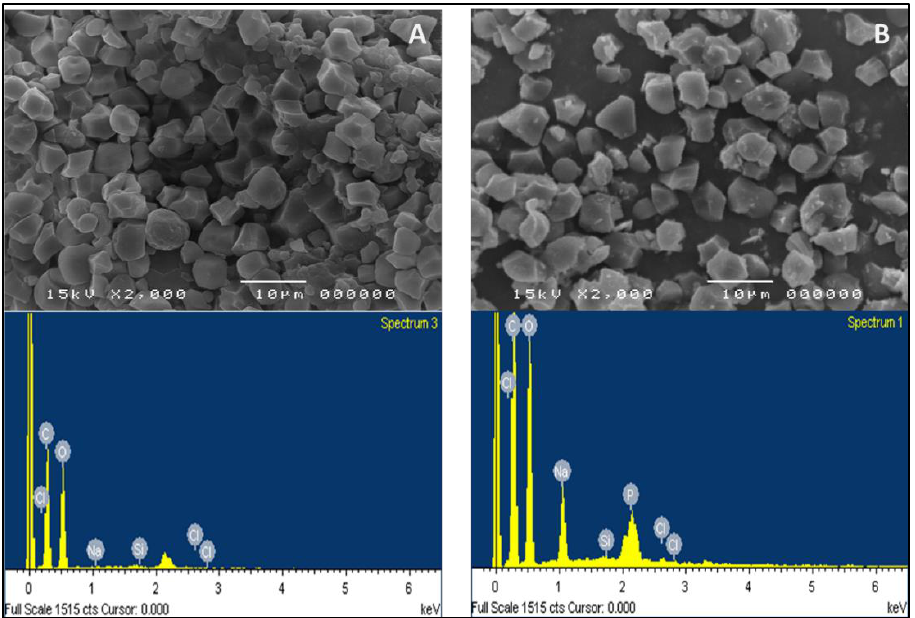
Figure 1. SEM ( top ) and EDX ( bottom ) images of ( A ) native rice starch (NRS) and ( B ) crosslinked carboxymethyl rice starch (CLCMRS) powders. SEM images taken at 2000 × magnification.